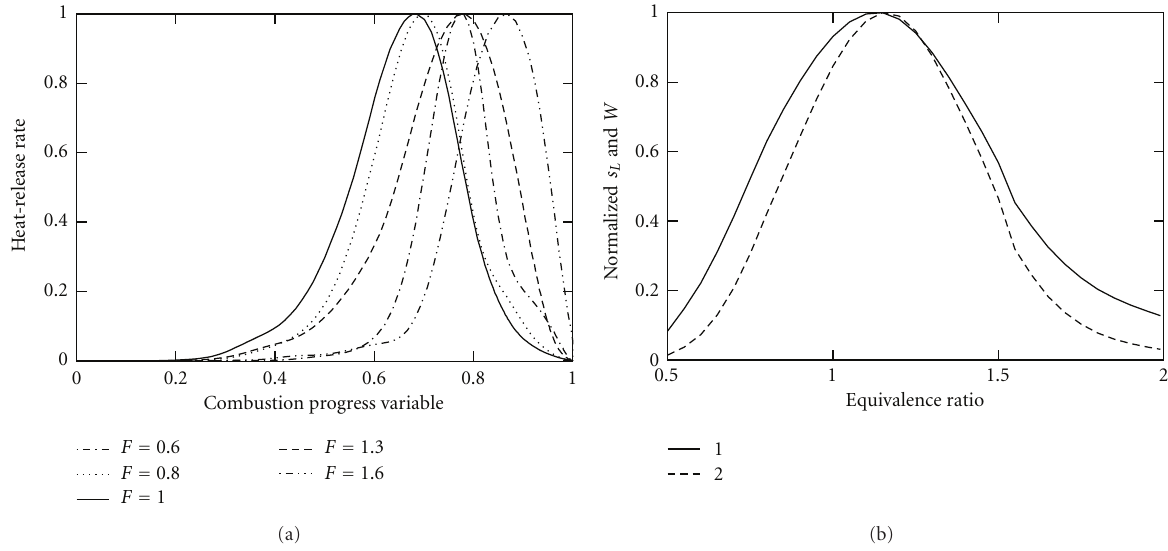
Figure 2: Data for averaging invoking presumed PDFs. (a) Normalized heat release rates w ( c ) versus combustion progress variable c , calculated for various gasoline-air mixtures, with the equivalence ratio being specified in legends. (b) Normalized laminar flame speed s L (solid curve) and maximum heat release rate Ω (dashed curve) versus equivalence ratio F .